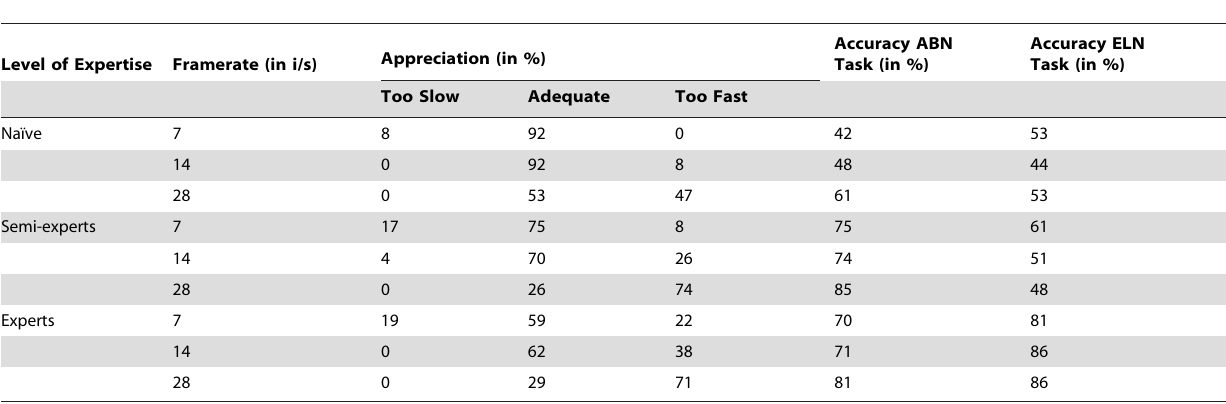
Table 3. Mean performance and appreciation of videos as a function of framerate.